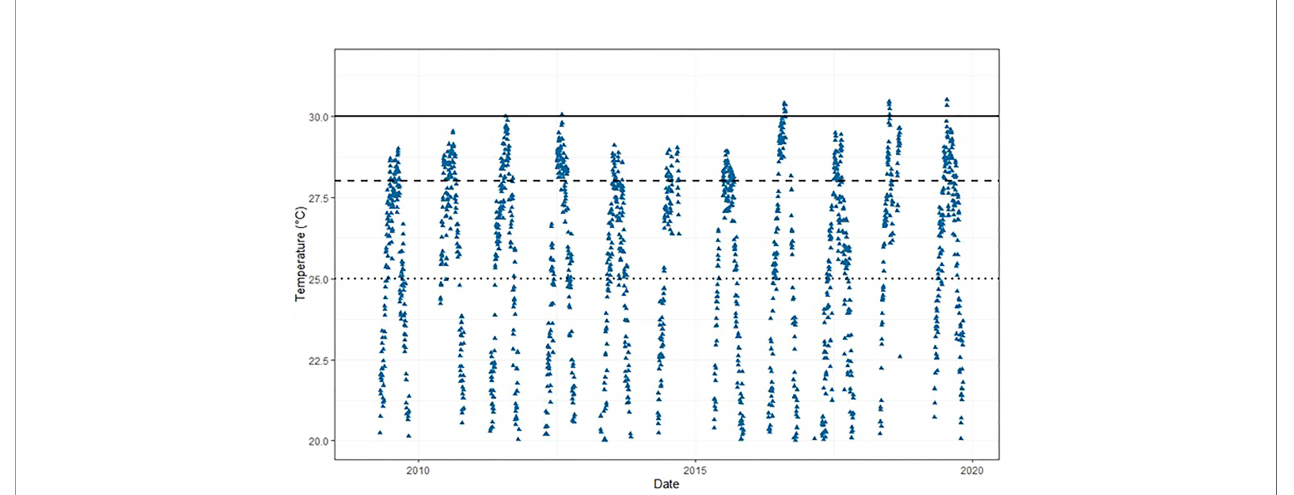
FIGURE 8 | Daily mean water temperature from 2009-2019 in Middle Marsh, Back Sound NC. Reference lines for established threshold values for stressful (25°C dotted lines), meadow decline (28°C dashed line), and lethal temperatures (30°C solid line) are shown in